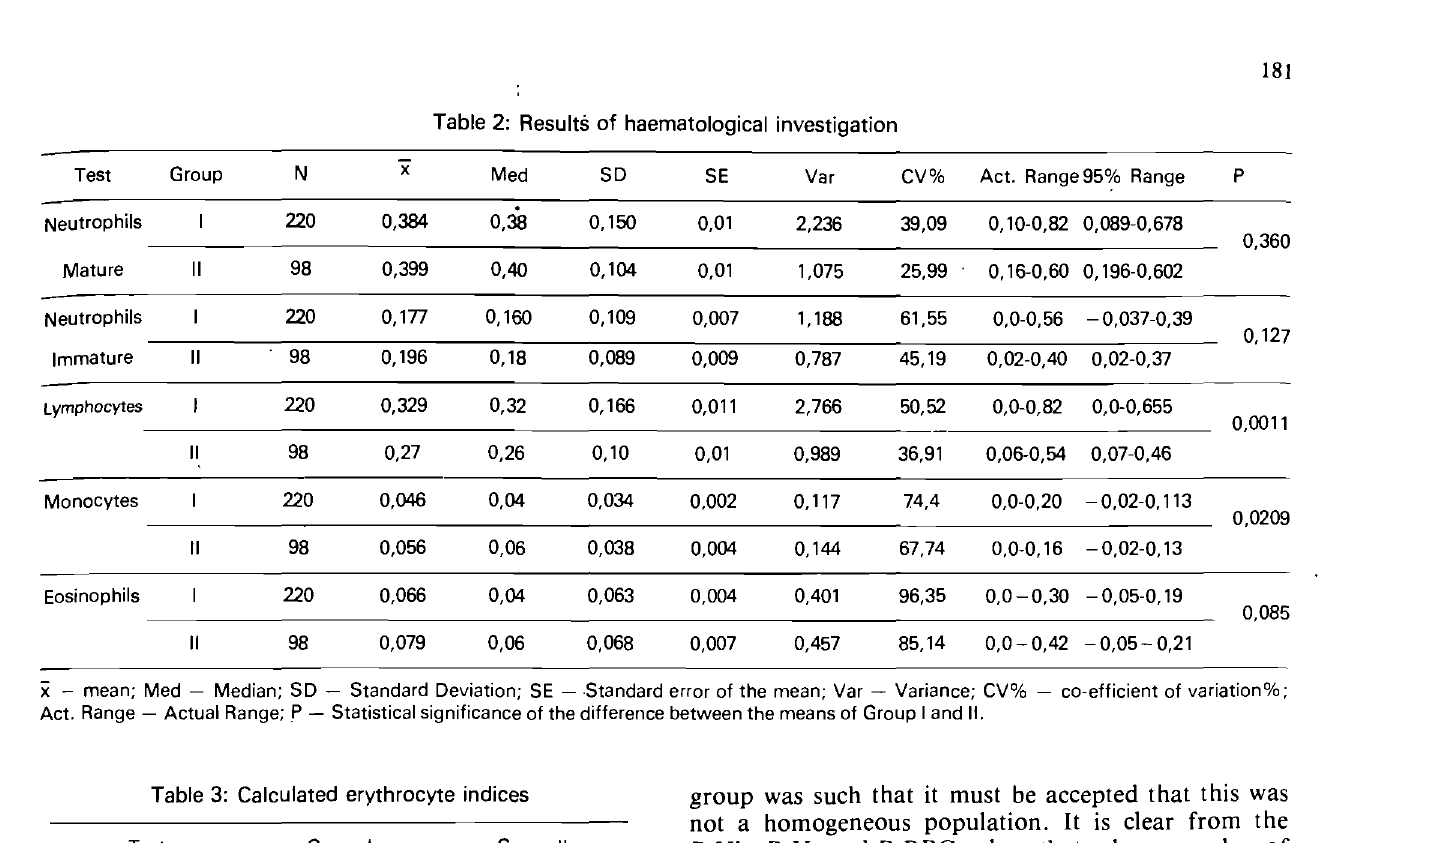
Table 3: Calculated erythrocyte